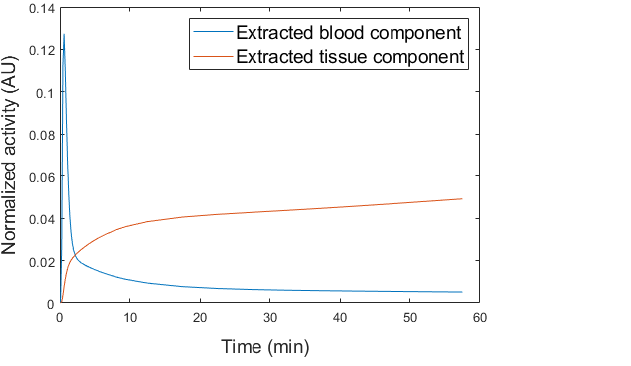
Table 1. Comparison between the V T,AIF and V T,IDIF in the blood-sampling cohort. Overall error is − 5.8 ± 7.8% for V T,IDIF when compared to V T,AIF . The error does not appear to be dependent on the target region.